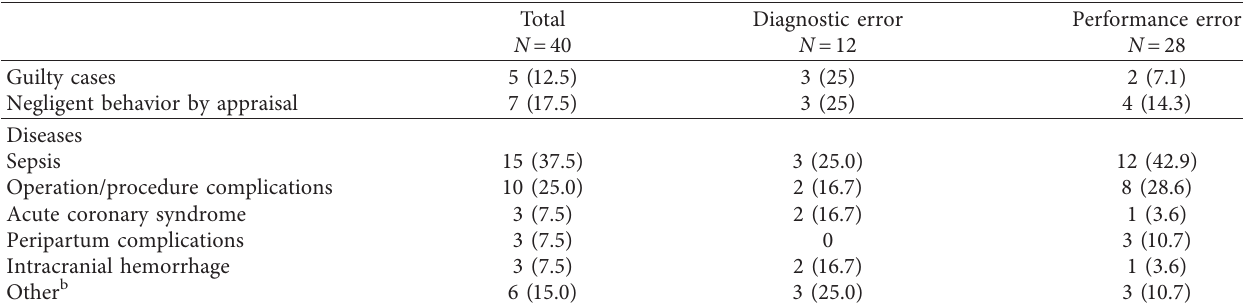
Table 4: Numbers and percentages of primary dispute types resulting in litigation categorized by disease a